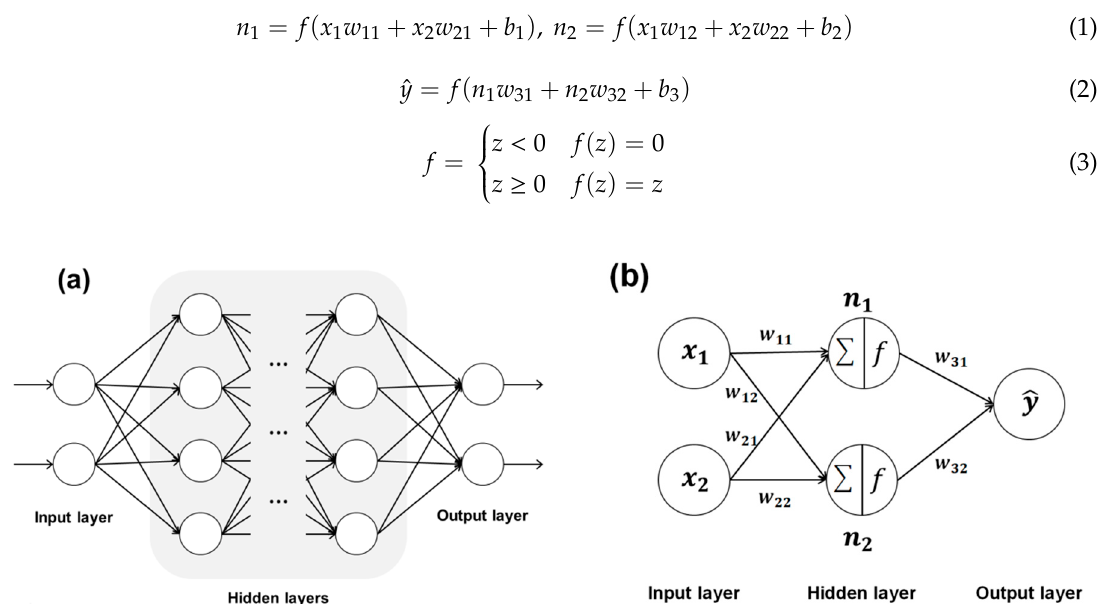
Figure 2. Description of DNN model: ( a ) structure of DNN model; ( b ) process for forecasting output through DNN model.